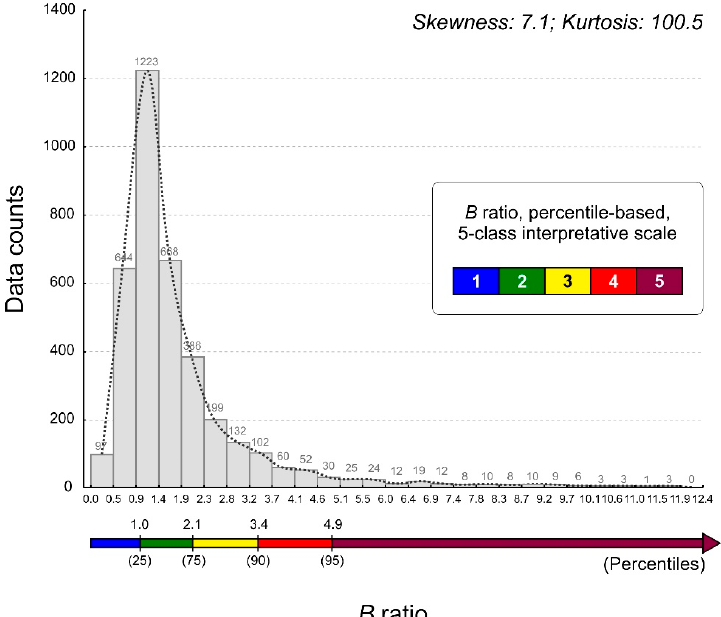
Figure 1. B ratio data distribution with indication of data counts per interval, skewness and kurtosis, and percentile values corresponding to the thresholds defining five bioaccumulation classes (the B ratio axis ends at the first ‘zero’ count).